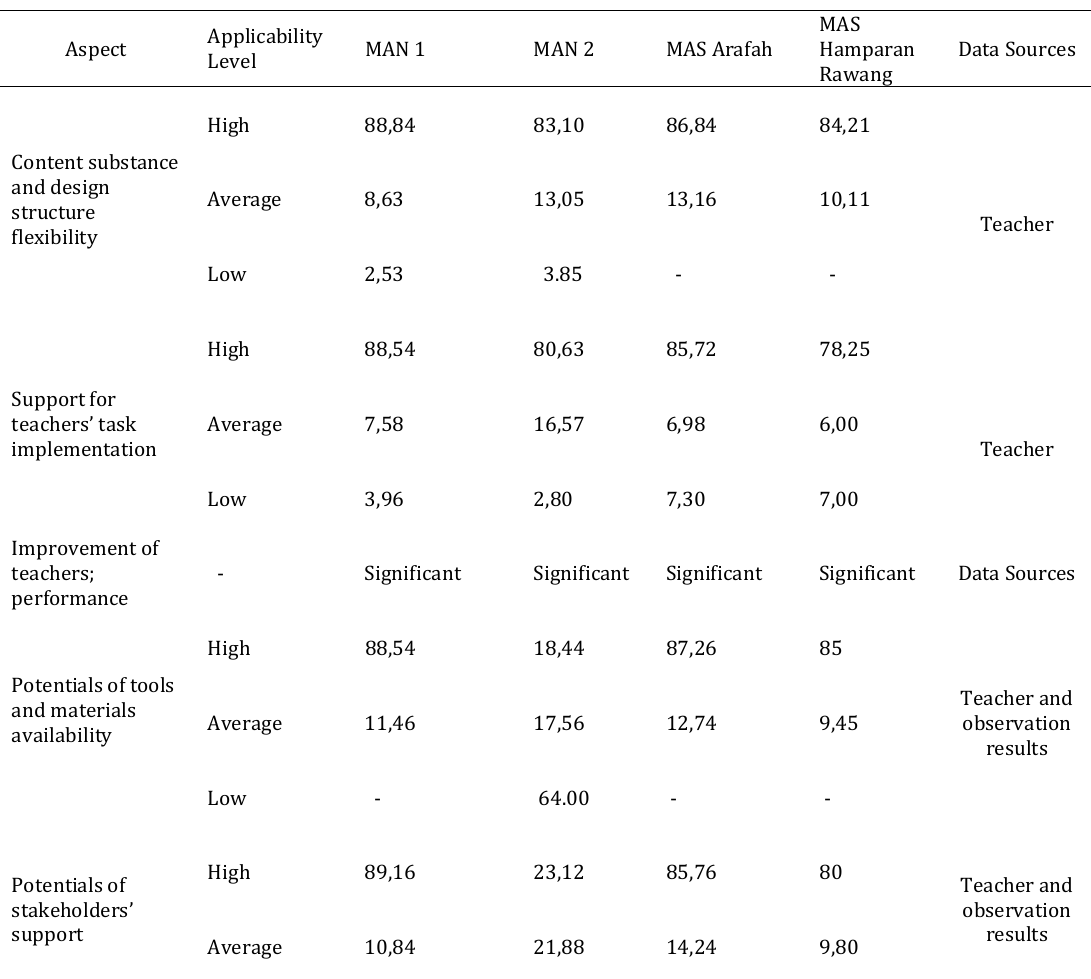
Table 7 Observation Results of the Applicability Level of Academic Supervision